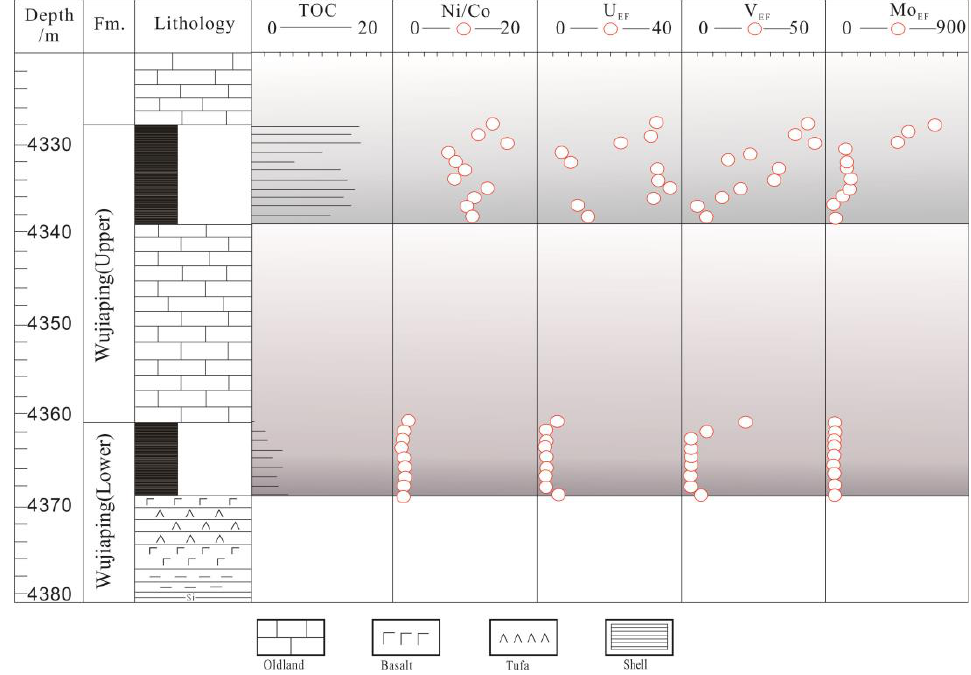
Figure 4. Redox index distribution characteristics of the Wujiaping Formation’s shale samples.